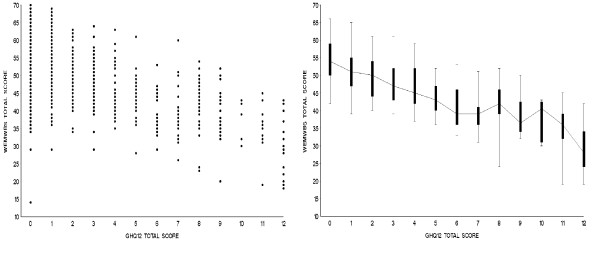
WEMWBS score vs. GHQ-12 score, scatter plot and box and 90% CI whisker plot: population sample.